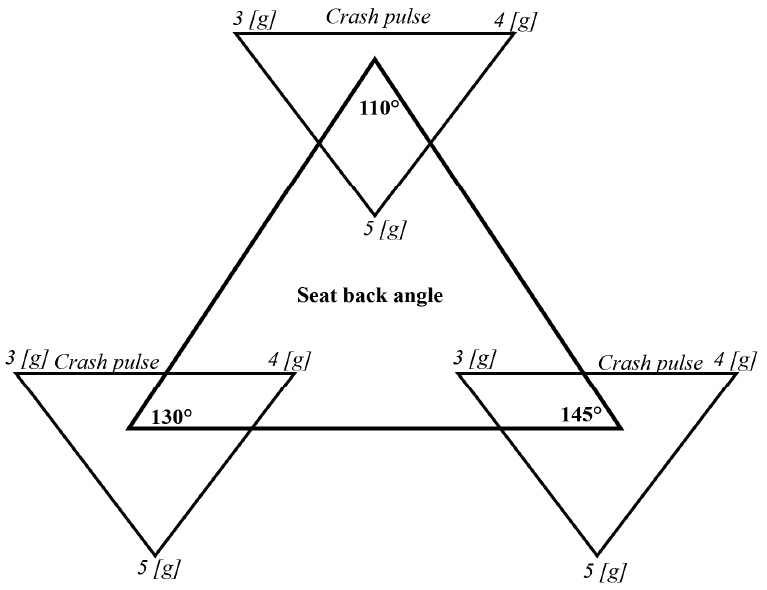
Figure 2. Schematic representation of the design of experiment.